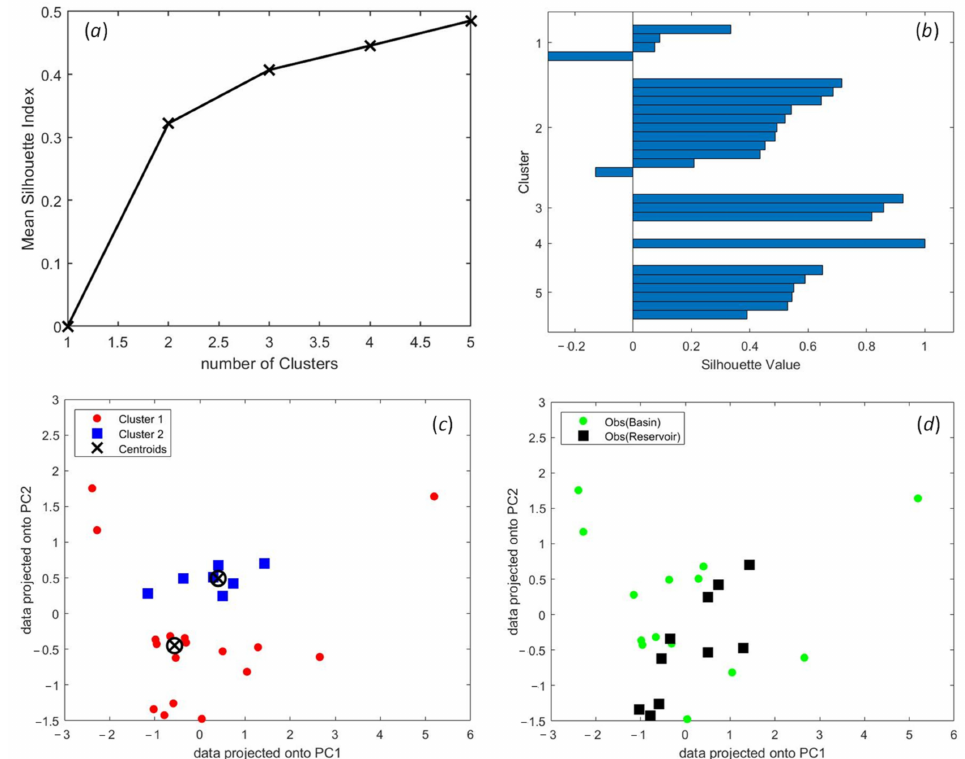
Figure 8. K-mean clustering results: ( a ) evolution of Silhouette indices with the number of clusters, ( b ) Silhouette indices calculated for each observation point while clustering measurements into two categories, ( c ) water quality sampling data (in principal component space) clustered in two groups, ( d ) original measurements obtained in drainage basin and the ones collected in the reservoir projected (separately) into principal coordinate systems.